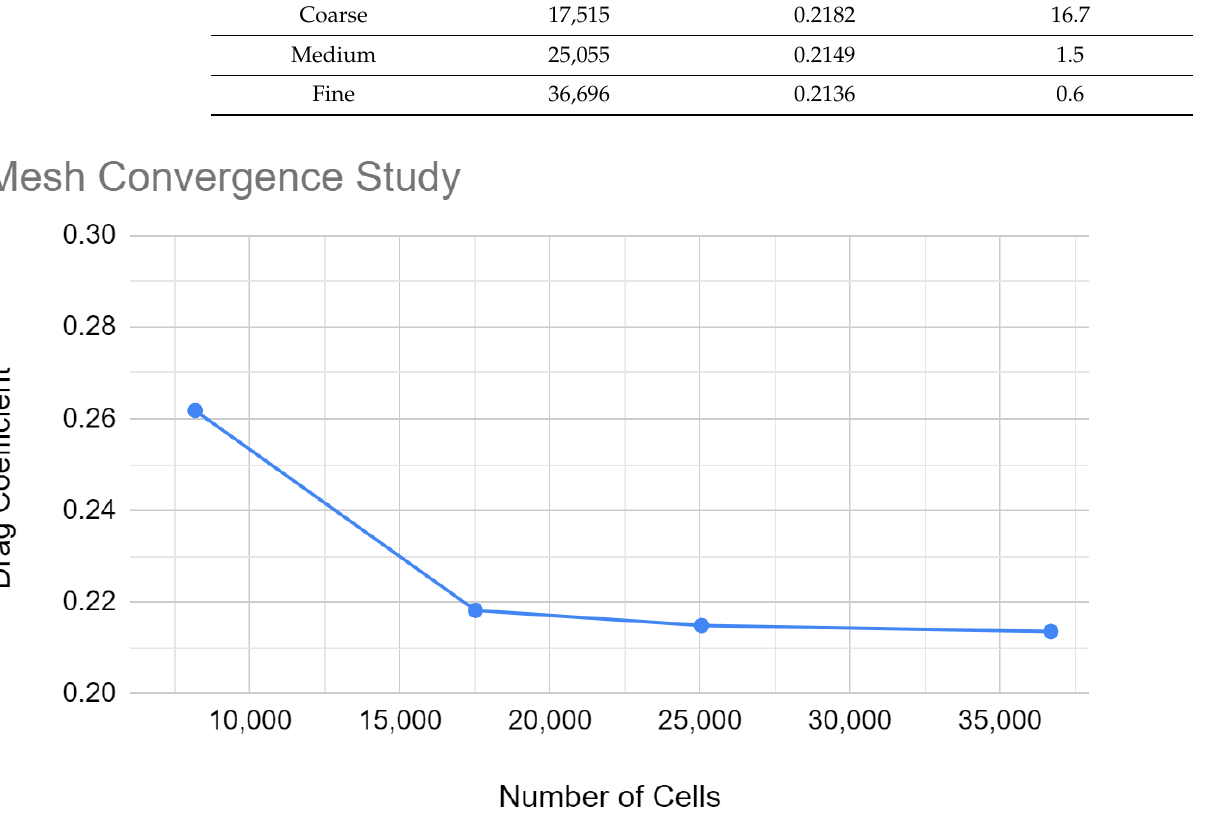
Figure 6. Graph of Mesh Convergence Study.